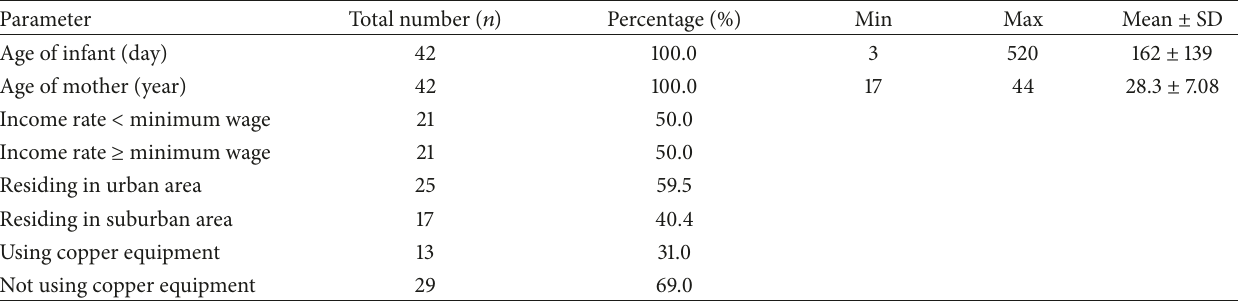
Table 1: Data of nursery mother and the infants’